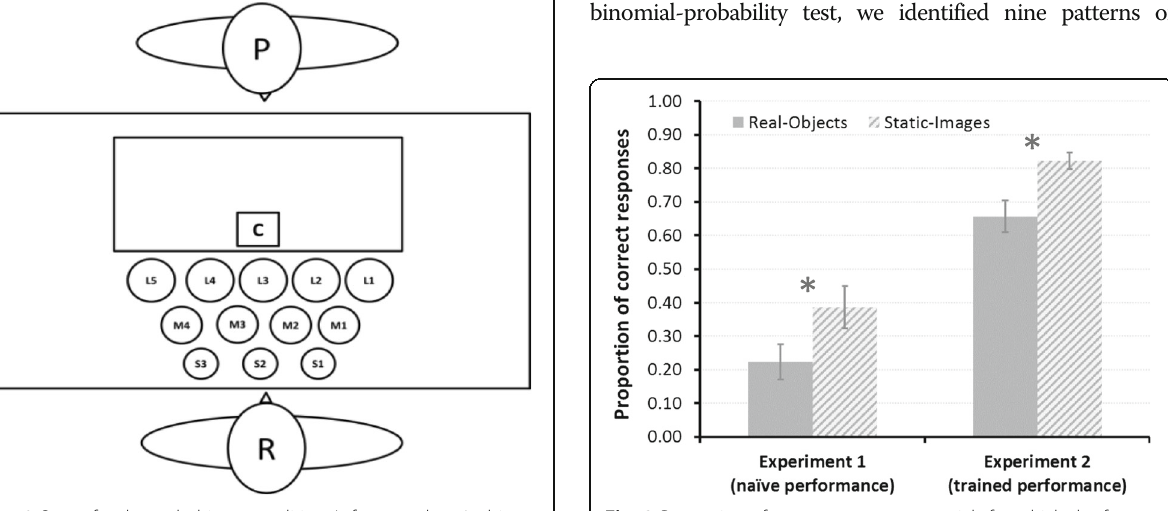
Fig. 2 Setup for the real-objects condition. It features the 12 objects in front of the researcher ( R ) and an opaque box with a camera ( C ) in front of the participant ( P )